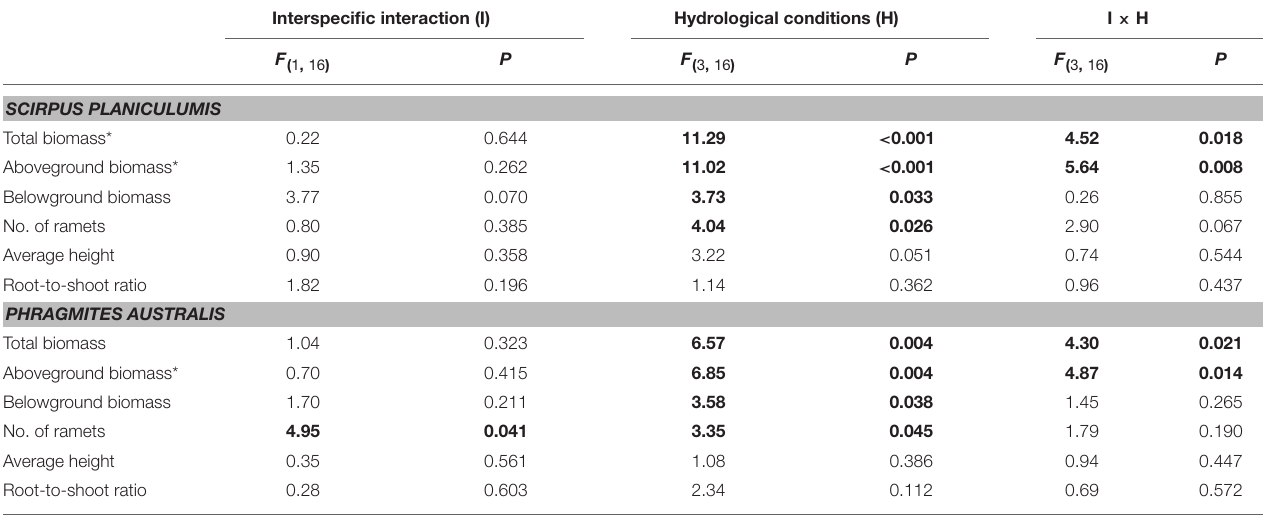
Frontiers in Plant Science |